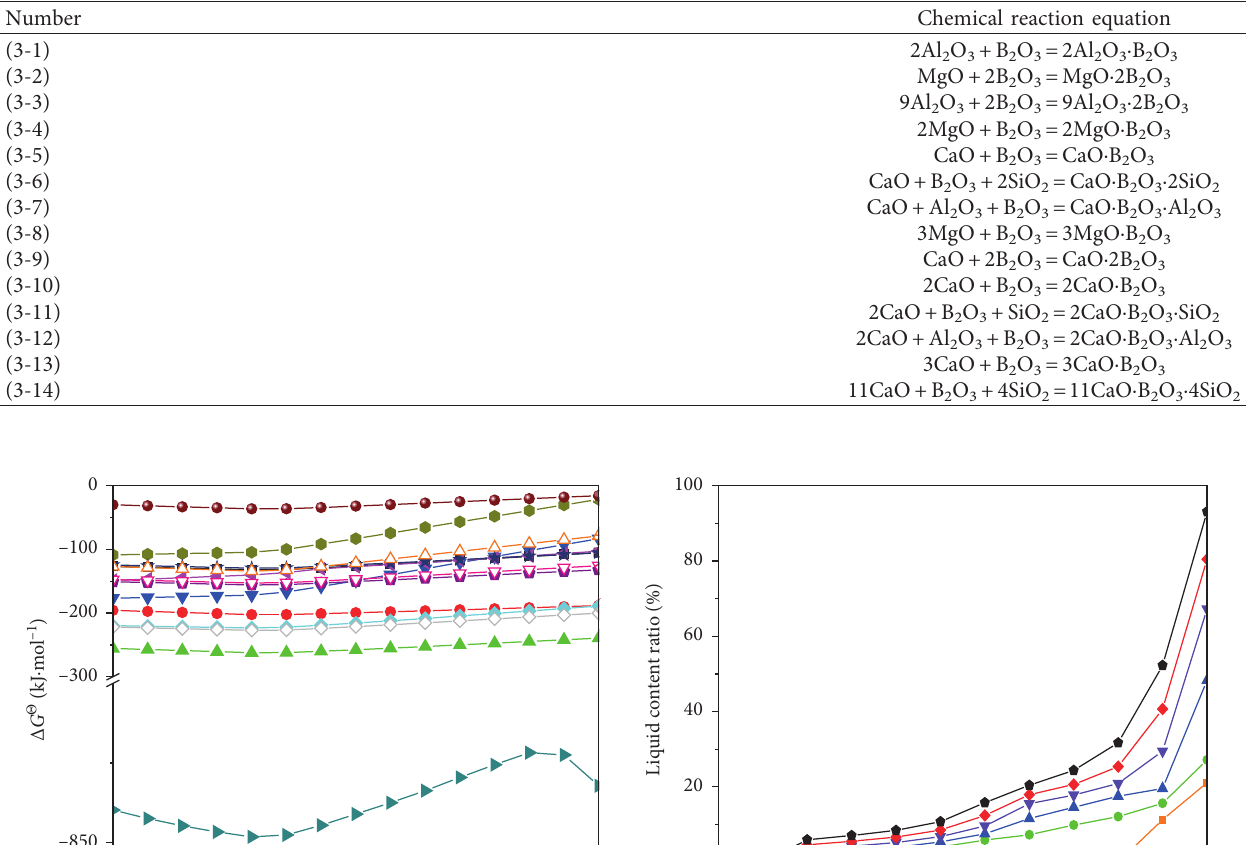
2 O 3 and oxides.